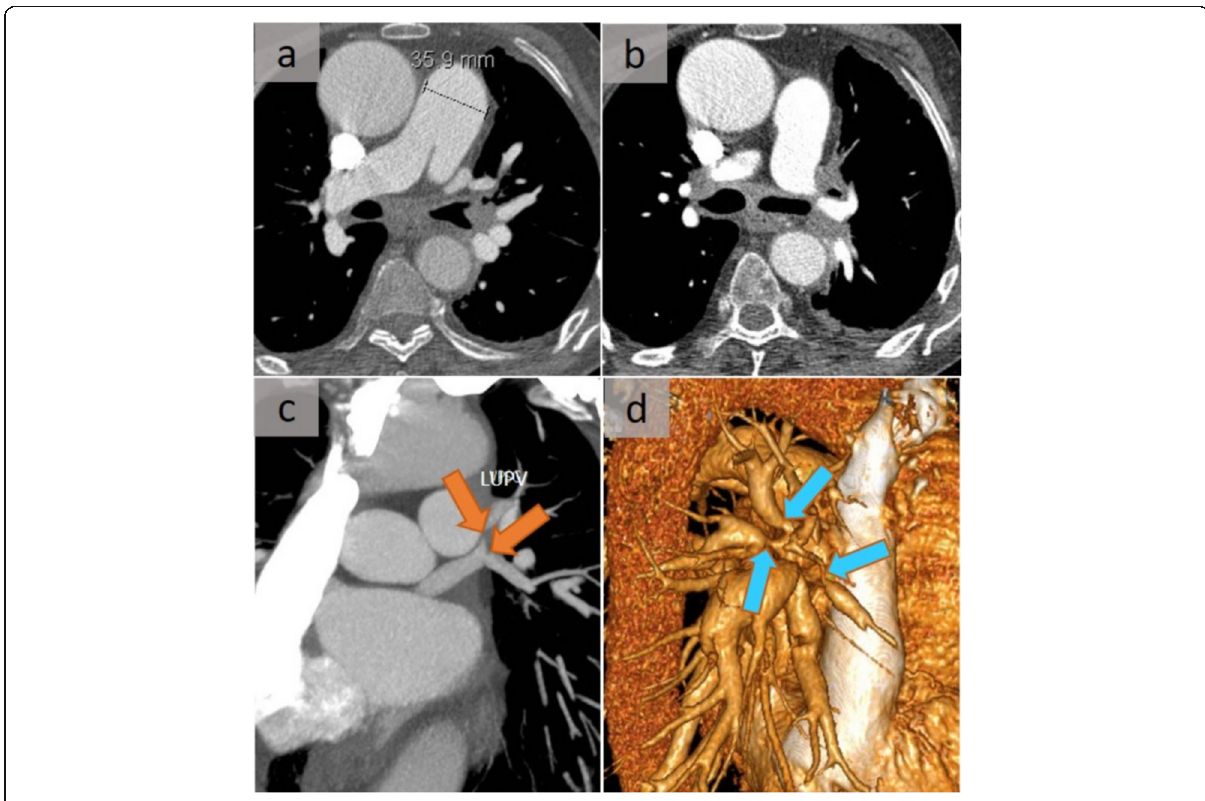
Fig. 9 Post-mediastinitis venous complication. A patient with sclerosing mediastinitis. In addition to the encasement of the pulmonary artery, there was a narrowing of the pulmonary veins, well assessed on the successive CT slices ( a , b ), as well as on the oblique reformation (orange arrows) ( c ) and 3D view (blue arrows) ( d ). Diagnosis was delayed due to confounding factors related to a history of pulmonary embolism